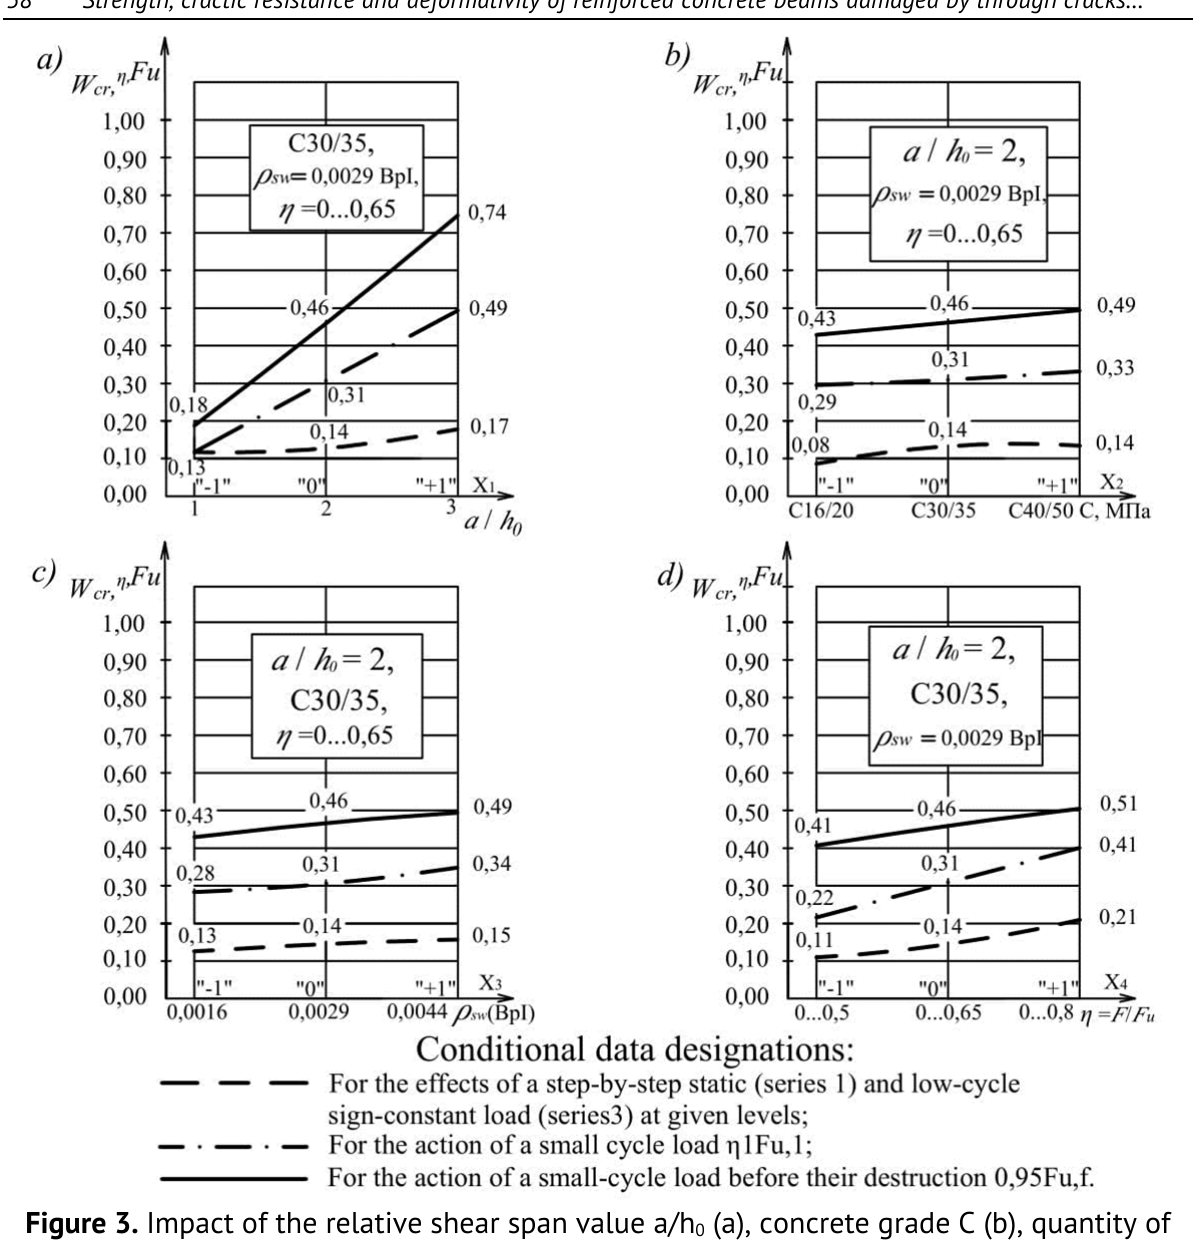
( а ), concrete grade С (b), quantity of Figure 3. Impact of the relative shear span value а /h 0 transverse reinforcement ρ (c) and level of low-cycle repeated loading ɳ (d), on the sw opening width of normal cracks in the “pure bend” zone in the middle of the beams at the level of tensioned